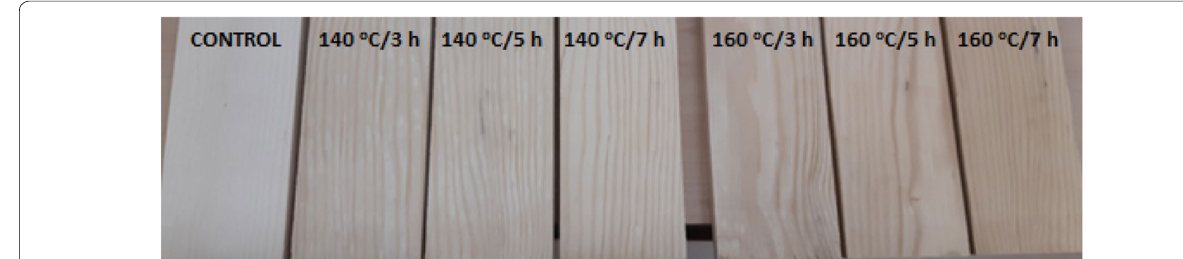
Fig. 4 Color change in fir after heat treatment